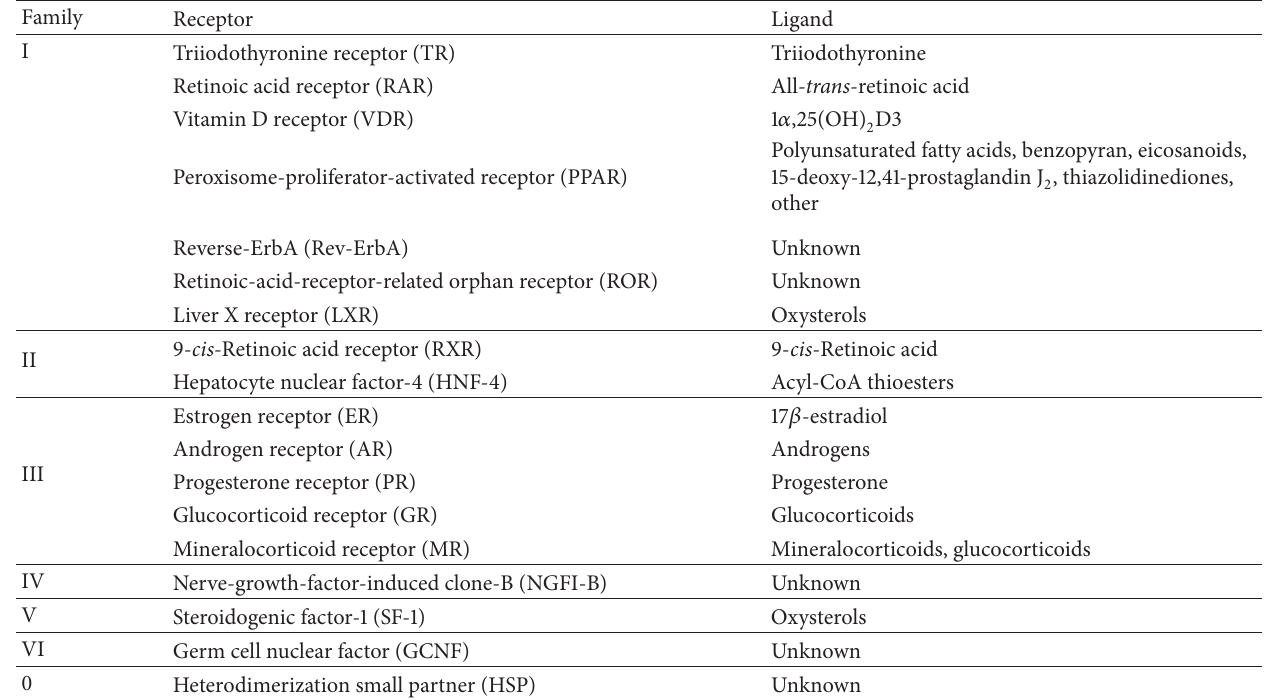
Table 1: Selected representatives of the nuclear receptor